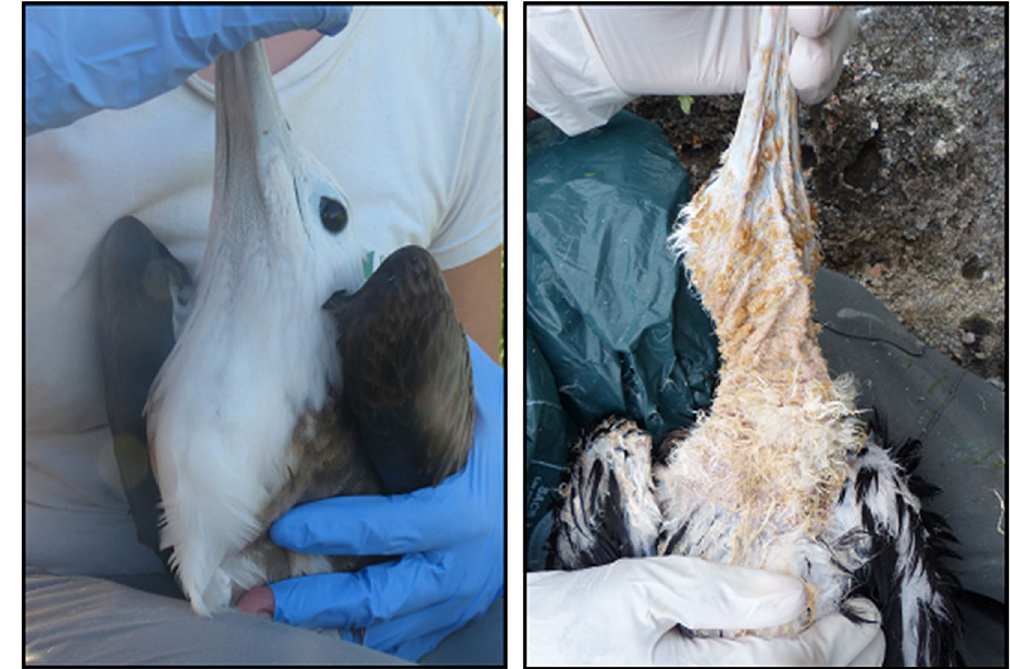
Figure 1. A healthy nestling (on the left) does not show clinical signs (hyperkeratosis, body and head crusts) in comparison to a sick individual (on the